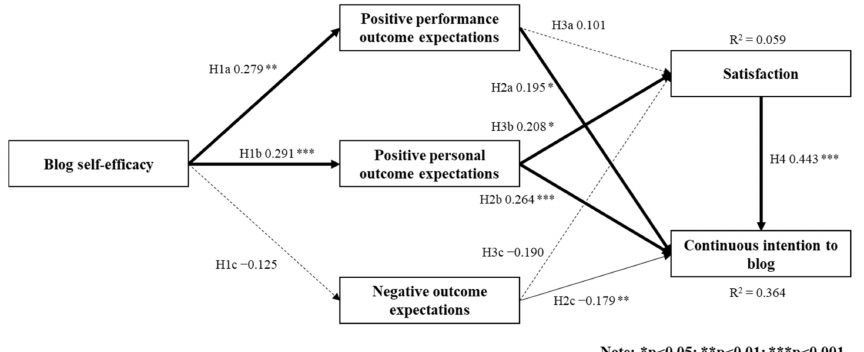
Figure 1. PLS analysis results of the structural model